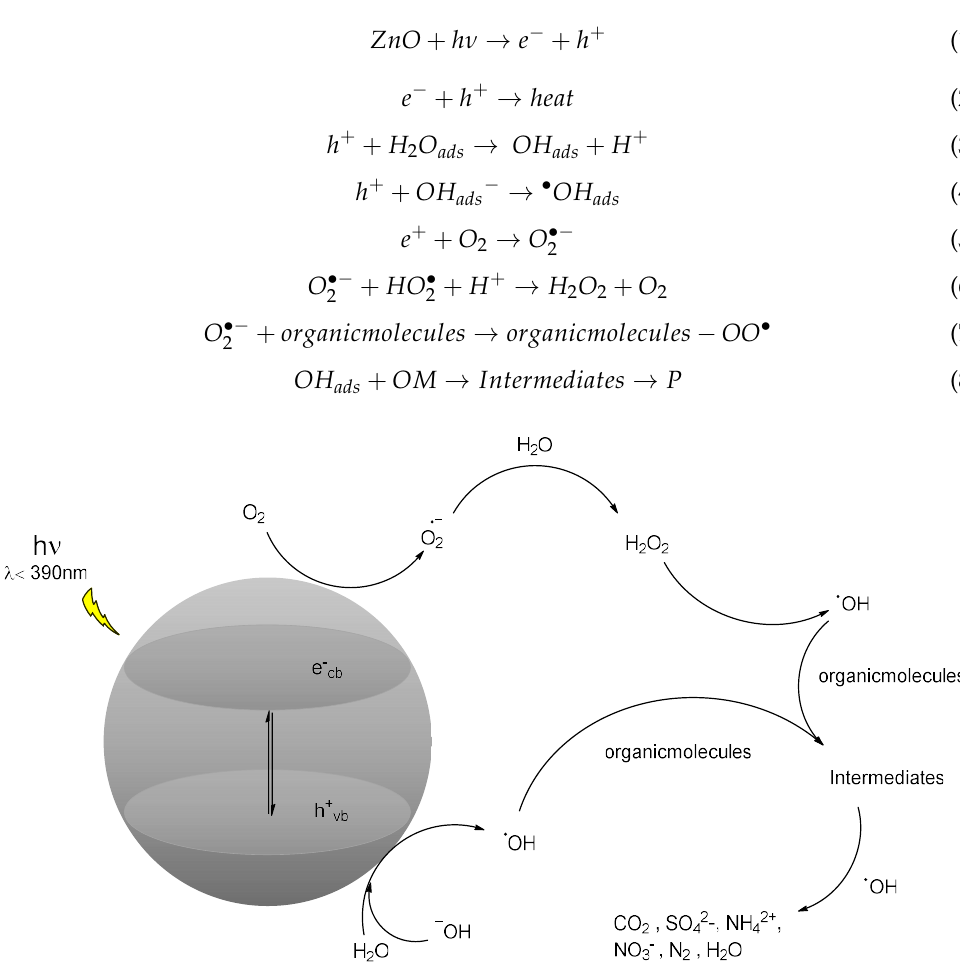
Figure 1. Diagram of reactions involving ZnO photocatalysis. Adapted from [6].